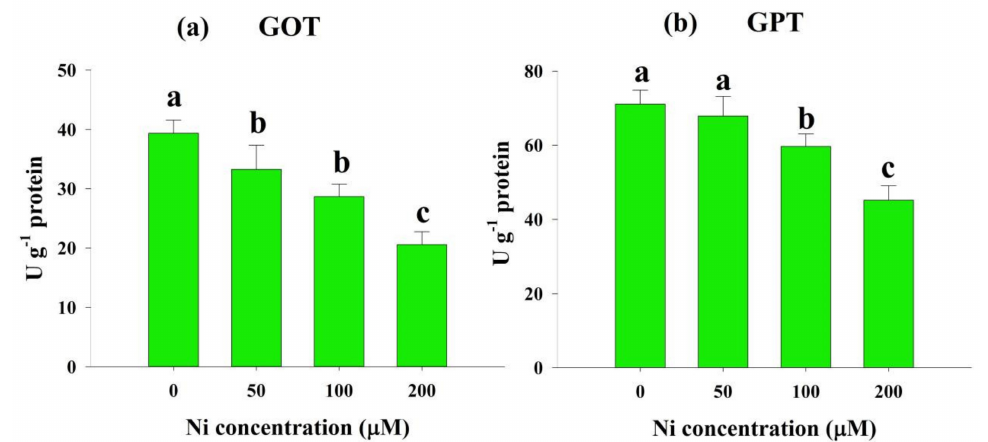
Figure 6. Effects of nickel (Ni) on the activity of glutamic oxaloacetic transaminase (GOT) ( a ) and glutamic pyruvic transaminase (GPT) ( b ) in the leaves of rice seedlings exposed to 0, 50, 100 and 200 µ M Ni for a period of 14 days. Bars represent means ± standard deviations (SDs) of three independent replications ( n = 3). Means followed by the same letter did not significantly differ among the treatments at p < 0.05, according to Fisher’s least significant difference